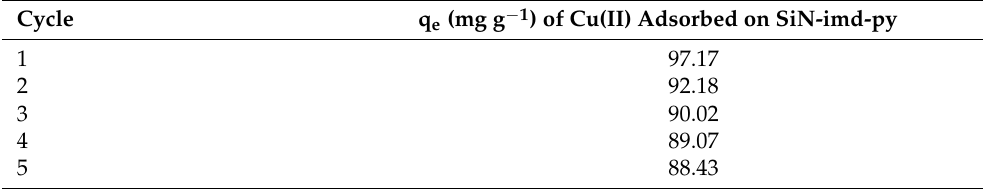
Figure 11. Metal ions selectivity effect for SiN-imd-py . Adsorption conditions: contact time = 25 min, V = 10 mL, pH = 6 at 25 ◦ C, m = 10 mg of adsorbent at optimum concentrations: 150 ppm of each studied metal Cu(II), Pb(II), Zn(II) and Cd(II). Table 6. Reusability and recycling of SiN-Imd-Py adsorbent towards Cu(II) in the adsorption– desorption cycles.